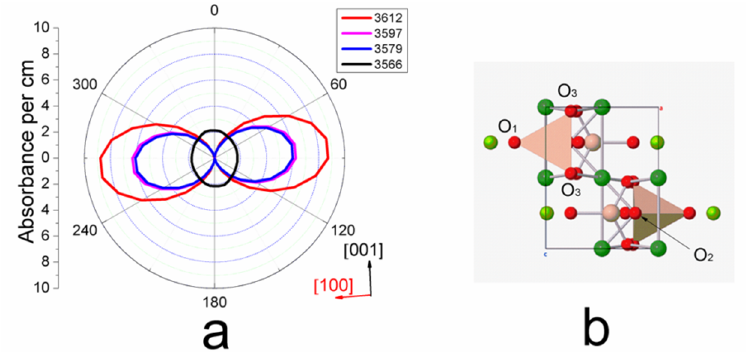
Figure 7. ( a ) The pleochroic scheme of the OH stretching band of the (100) plane of forsterite (ab- sorbance intensity vs. sample to polarizer angle). ( b ) Top view of the atomic structure of the (100) plane of forsterite crystals.